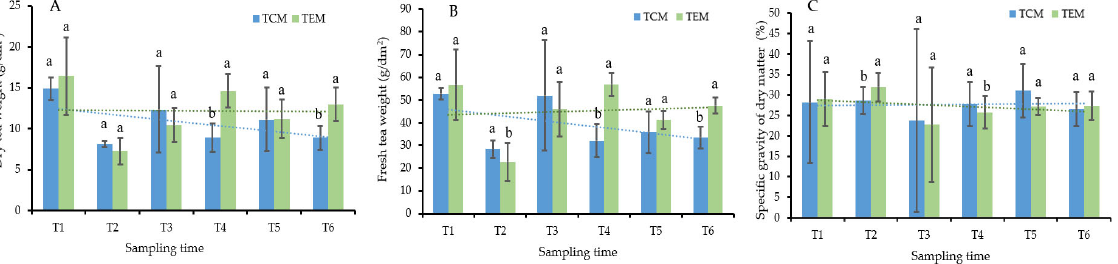
Figure 4. The effects of management mode on the tea production indices. The different letters labeled in columns are significantly different according to Duncan’s test ( p < 0.05). ( A ) Dry tea weight, ( B ) fresh tea weight, and ( C ) specific gravity of dry matter. TCM= tea conventional management;